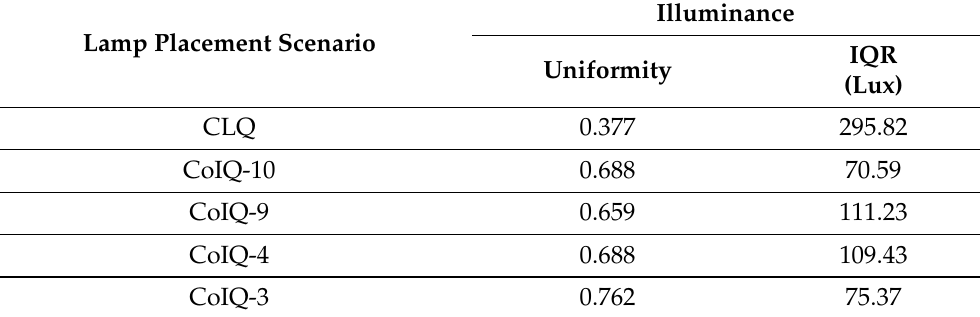
Table 2. Performance Metrics for